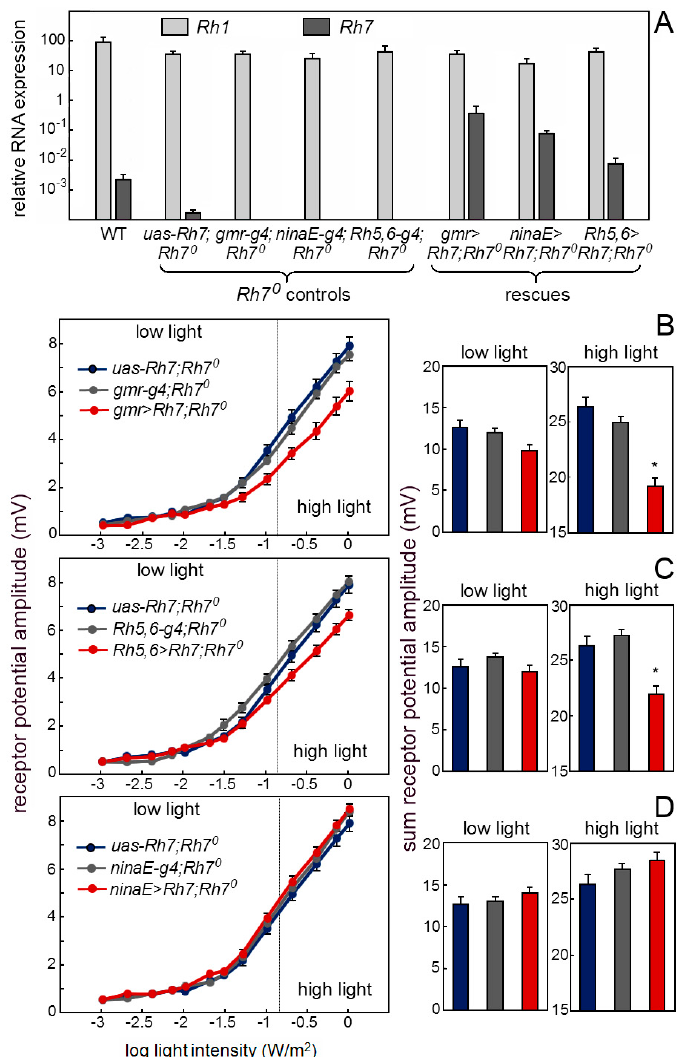
Figure 8. Rh7 expression in the receptor cells 8 rescues the wild-type ERG. ( A ) Rh7 expression revealed by qPCR in the retina of the wild-type controls, Rh7 0 mutant controls and flies, in which Rh7 was rescued in different receptor cells ( gmr > Rh7;Rh7 0 : all receptor cells; ninaE>Rh7;Rh7 0 : the outer receptor cells R1-6; Rh5,6>Rh7;Rh7 0 : receptor cell R8). ( B ) Irradiance response curves of the receptor potential amplitudes in the dark-adapted flies of the Rh7 0 mutant controls and the Rh7 0 mutants, in which Rh7 was rescued in all receptor cells ( gmr>Rh7;Rh7 0 ). Under high light, the presence of Rh7 in all photoreceptors significantly reduces the ERG amplitude. ( C ) Flies with Rh7 rescued only in receptor cells 8 ( Rh5,6>Rh7;Rh7 0 ) also showed significantly lower ERG amplitudes than the Rh7 0 controls at high light. ( D ) The ERG responses of the flies with Rh7 expressed only in the outer receptor cells ( ninaE>Rh7;Rh7 0 ) did not differ from the Rh7 0 controls. All flies were in a red-eyed y − w + -background to ensure equal eye color.